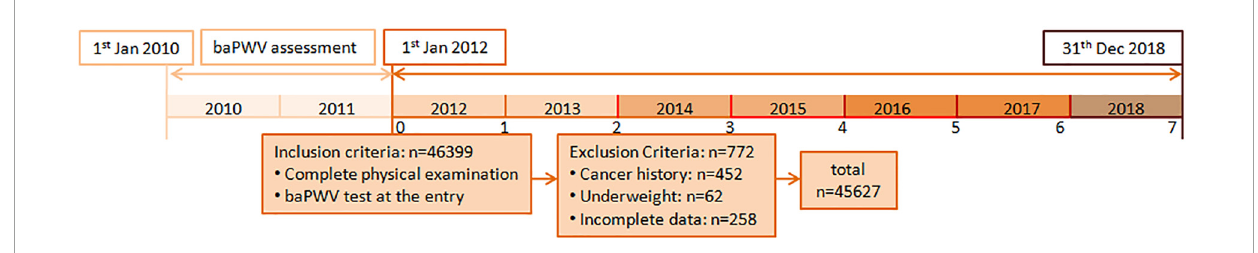
FIGURE1 The flow chart of this large cohort study. Participants who received baseline baPWV with biennial physical examinations were eligible for this study. The baseline baPWV was assessed from January 2010 to December 2011. Participants were followed up for cancer occurrence between January 2012 and December 2018. baPWV, Brachial-ankle pulse wave